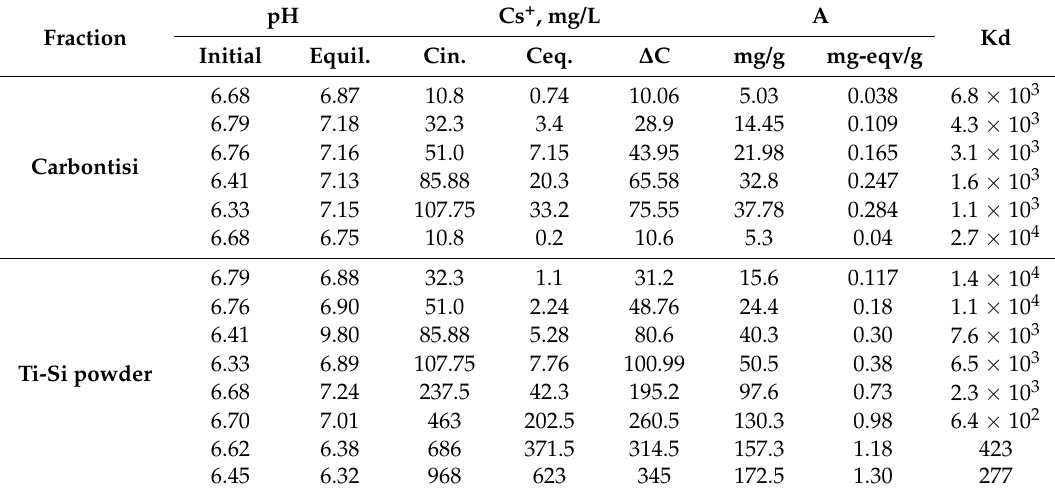
Figure 7. Strontium adsorption isotherms from the background 0.01M NaCl solution by sample 7. □ —TiSi-powder fraction; ♦ —Carbon-TiSi fraction; at low concentrations ( A ); at middle concentrations ( B ). Table 2. Cesium adsorption (A) and distribution coefficients (Kd) from the background 0,01M NaCl solutions onto the simple’s 7 Carbon-TiSi and Powder-TiSi fractions.